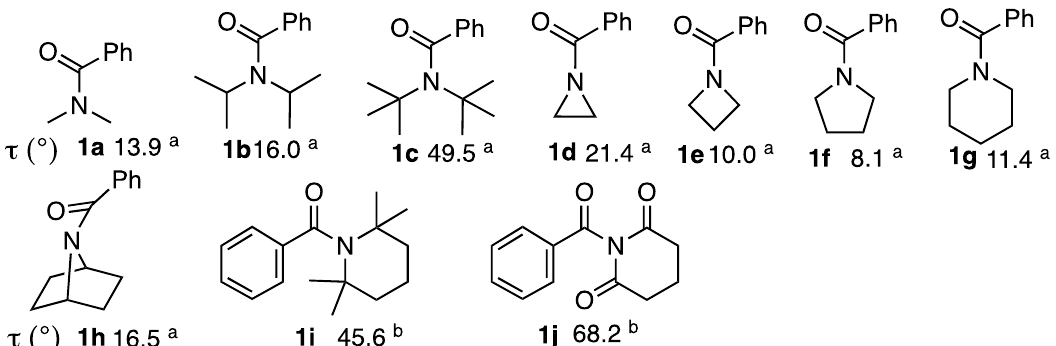
Figure 2. Distortion angles (τ) of ground-state-stable benzoyl amides. a B3LYP/6-31 + G(d) level of theory (Reference [14]). b X-ray data (Reference [15]). Calculated dihedral angle τ . τ = ( ω 1 + ω 2 )/2